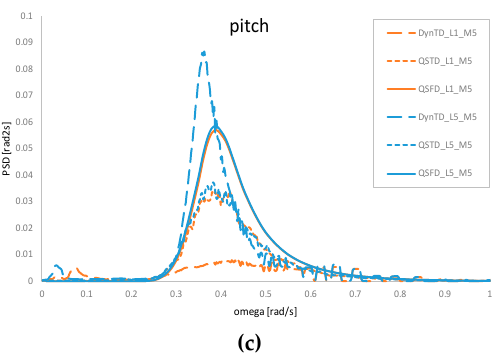
Figure 8. Power spectral densities in surge (WF magnified 20 times) ( a ), heave and pitch motions (WF reduced by a factor of 2) ( b ) and ( c ) comparing models’ performance with the largest and lowest non-dimensional pretension.